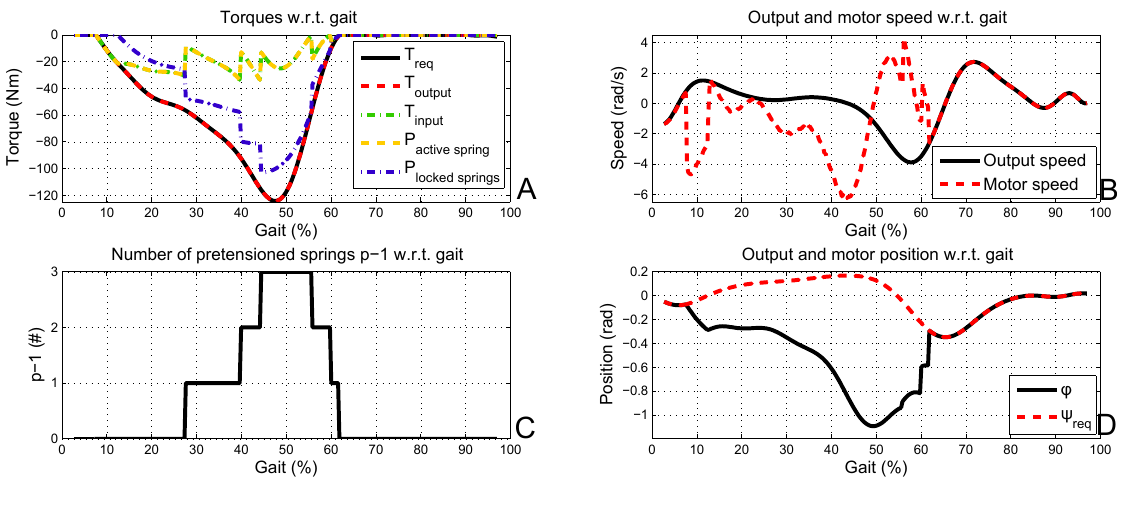
Figure 6. The SPEA simulation results. Figure (A) clearly illustrates that the motor torque at the input side, T , is lower compared to the required output torque, T input of pretensioned springs p-1 rises to 3 as indicated in (C). As a result, the maximum motor position, ϕ , and speed, ω , are increased compared to the output angle, ψ m m ω , in (D) and (B). req